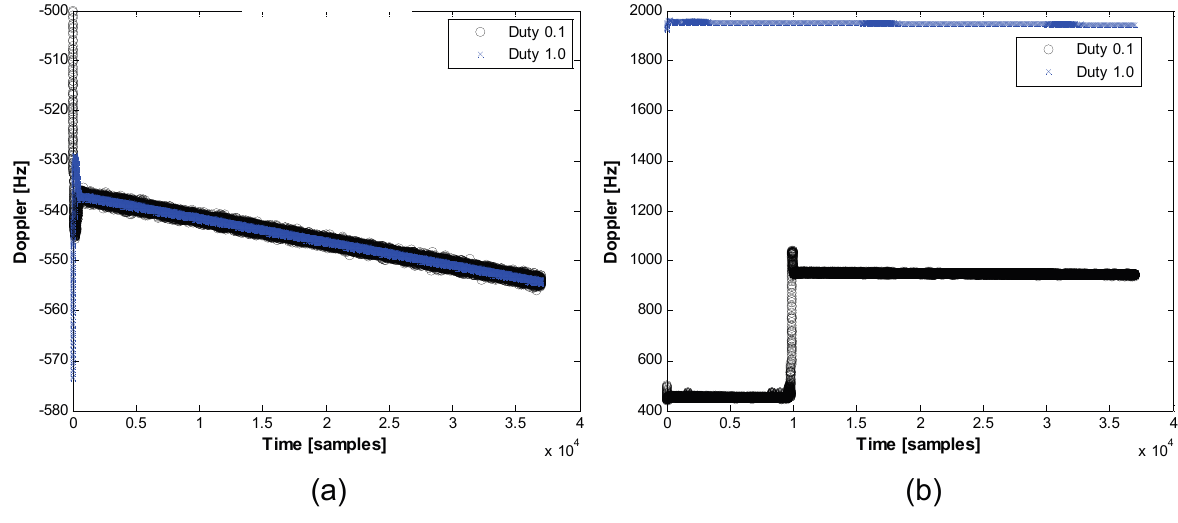
Figure 8. Estimated Doppler: ( a ) correctly locked; ( b ) falsely